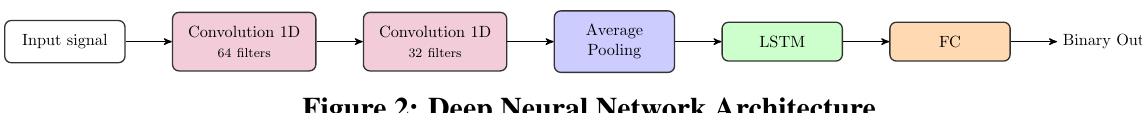
Figure 2: Deep Neural Network